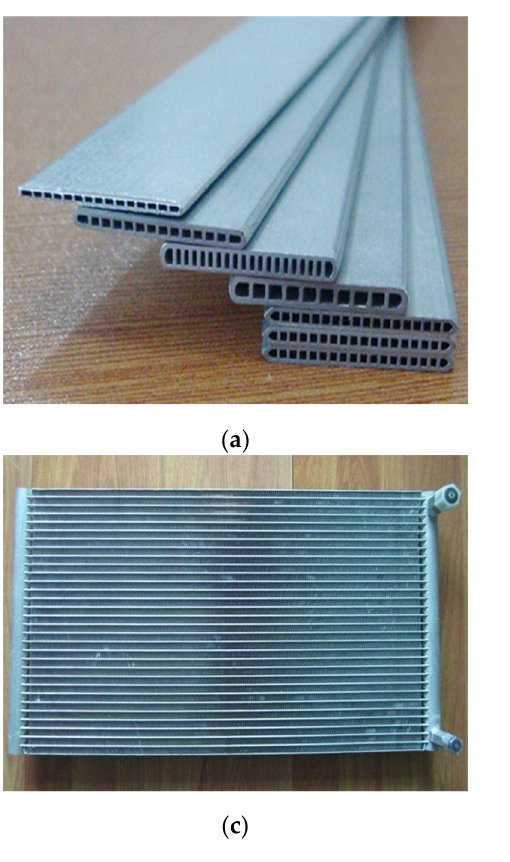
Figure 7. Structure of a micro − channel condenser: ( a ) porous micro − channel tube; ( b ) header; and ( c ) micro − channel condenser.